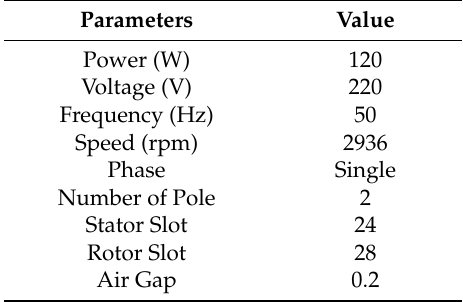
Table 1. Parameters of model for the SPIM analysis.